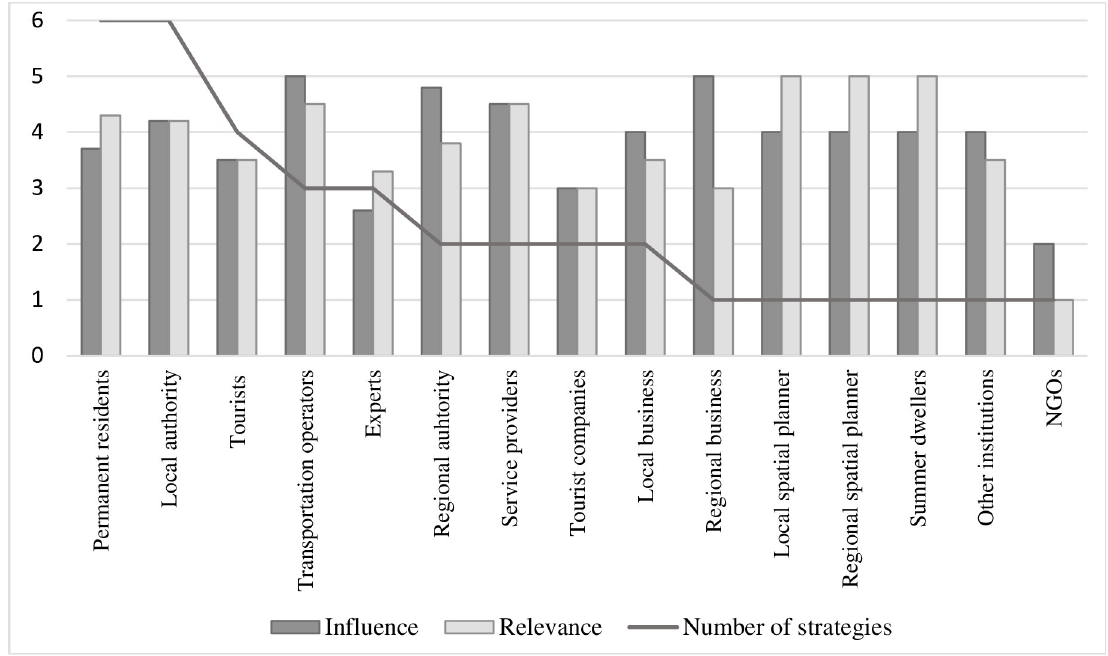
Fig 3. Number of strategies in which stakeholder groups were mentioned and average scores of influence and relevance of given group (1 = low– 5 = very high) in six regional stakeholder involvement strategies. Source: own